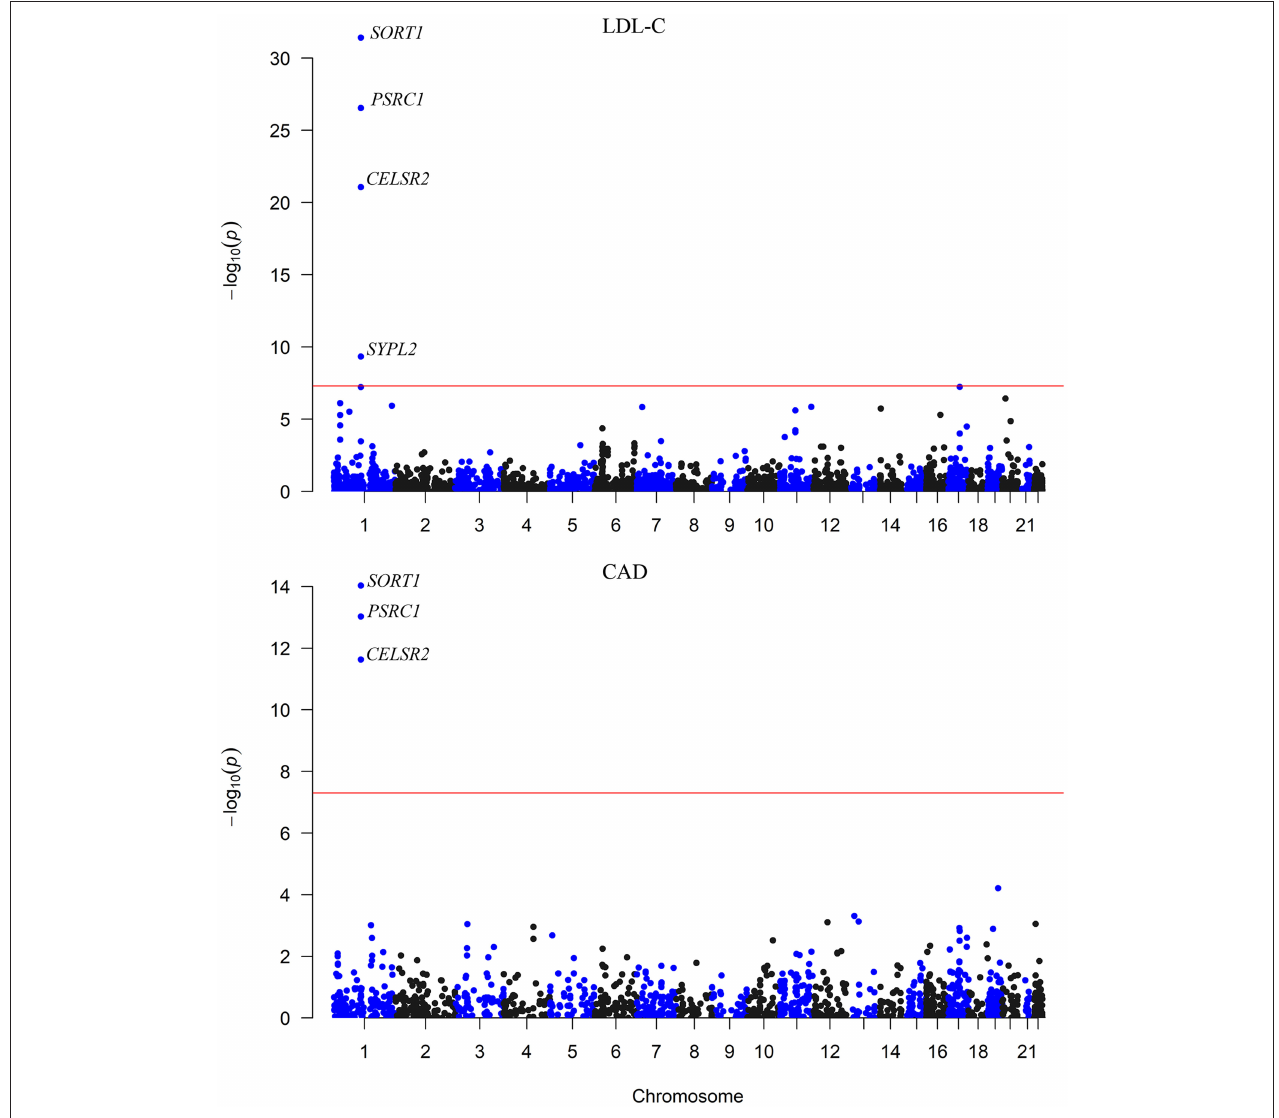
FIGURE 1 | The association between mRNA expression levels and LDL-C and CAD in the liver. The x-axis represents the chromosome positions. The y axis shows the –log 10 P -values for the association between mRNA expression levels in liver cells and LDL-C and CAD. The associations of mRNA expression levels of SORT1 , PSRC1 , and CELSR2 in liver cells with both LDL-C and CAD passed the significance threshold of 5.0 × 10 − 8 (red line).